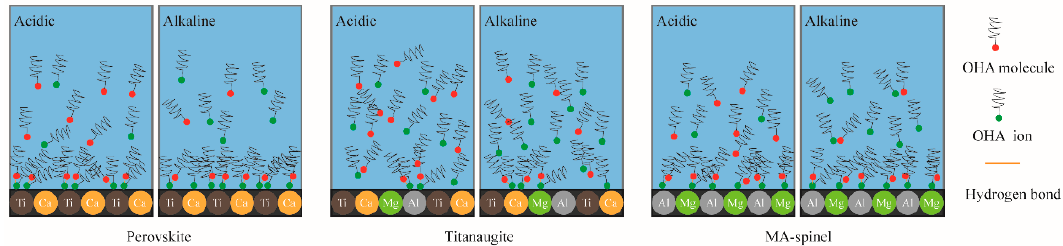
Figure 11. Proposed adsorption model of OHA reacted on perovskite, titanaugite, and MA-spinel surface in different pH solutions.